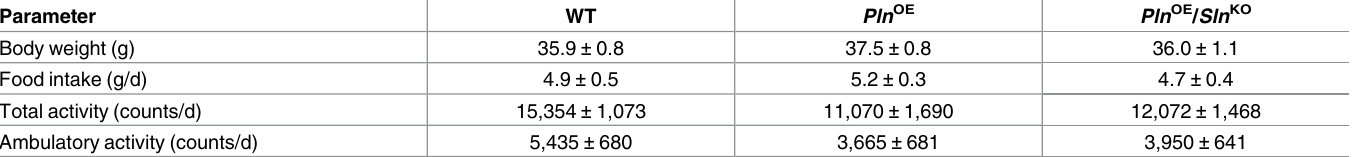
Values are means ± SEM (n = 18–23, for the average body weight of Pln WT / Sln WT , Pln OE / Sln WT , and Pln OE / Sln KO mice; n = 6 per genotype for daily food consumption, ambulation, and total activity). Ambulatory activity counts were when the mouse crossed 2 adjacent x-axis infrared beams in succession. One-way ANOVA revealed no significant effect of genotype for body weight ( p = 0.37), food intake ( p = 0.48), total activity ( p = 0.12), or dual beam activity ( p =